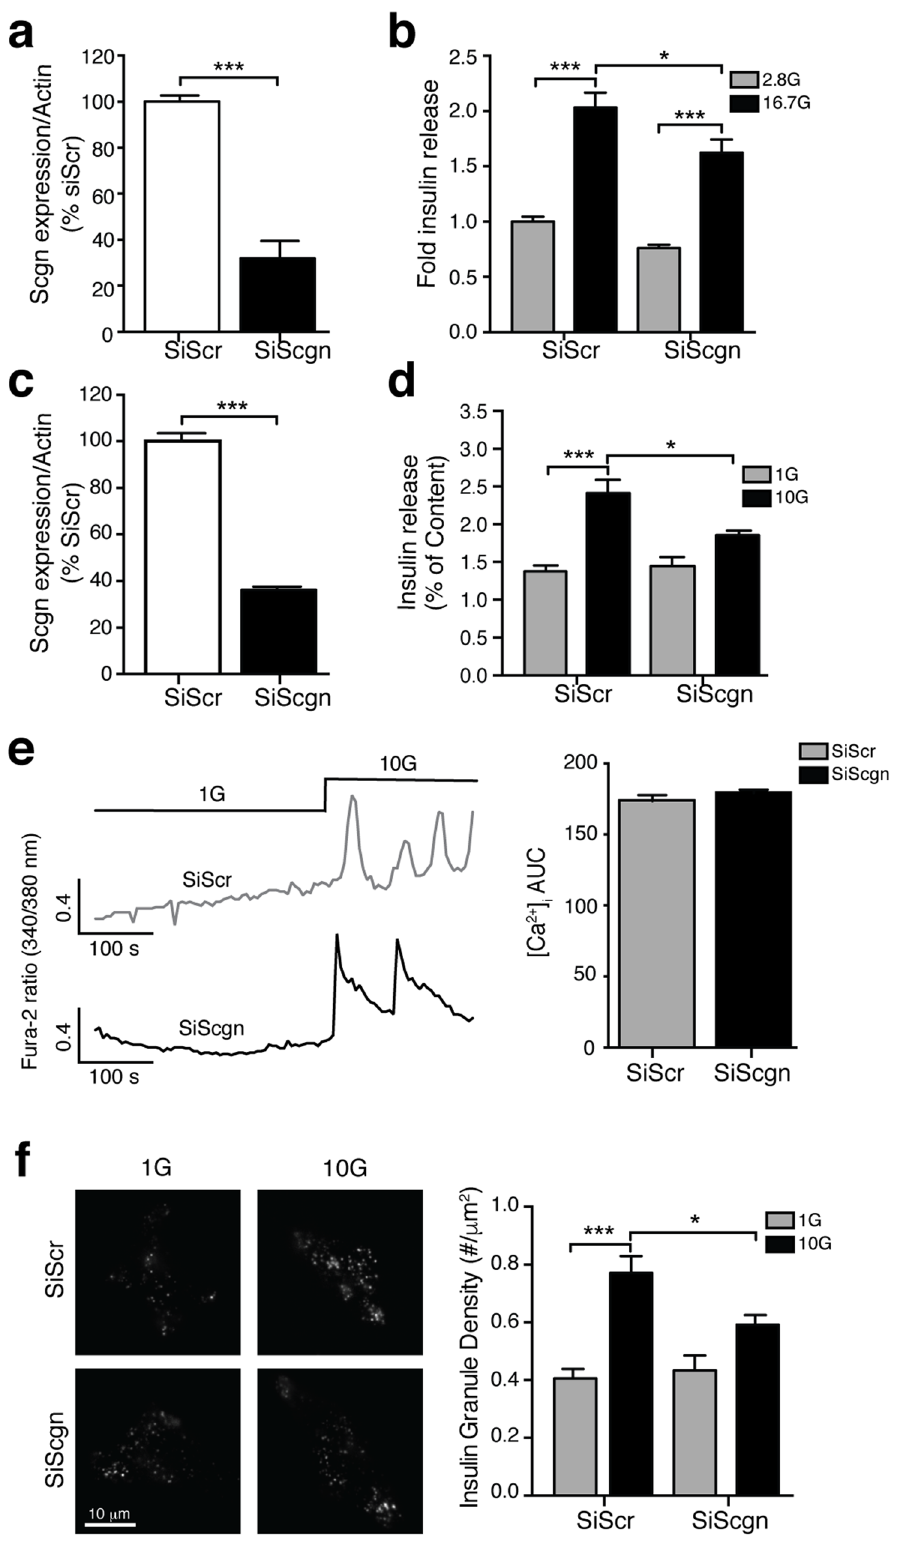
Figure 3. Secretagogin controls insulin secretion downstream Ca 2 + influx. ( a–d ) Transient transfection of dispersed human islet ( a,b ) and INS 832/13 cells ( c,d ) with SiScgn reduced mRNA expression ( a,c ) and glucose- induced insulin secretion ( b,d ). ( e) The glucose-induced [Ca 2 + ] i response is not modified upon reduction of secretagogin expression (n = 158, 166 cells from 3 independent experiments). ( f) The recruitment of insulin granules marked by NPY-Venus in response to 10 mM glucose for 15 minutes is reduced in INS 832/13 cells transfected with SiScgn. (n = 32–46 cells from 4 independent experiments). * p < 0.05, *** p <